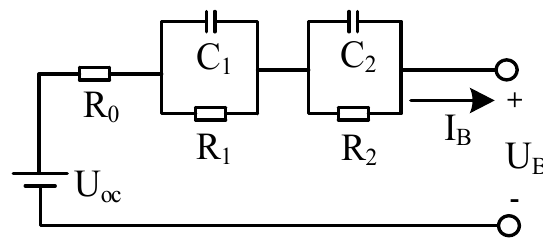
Figure 6. Model structure of the battery.